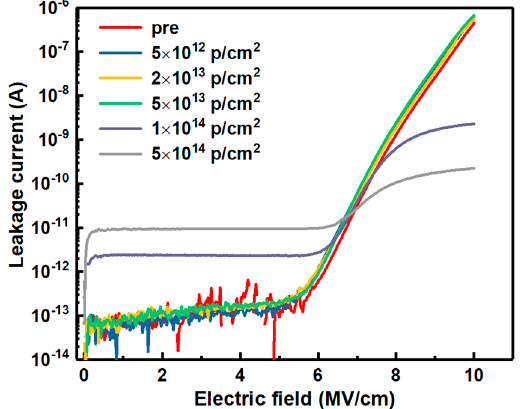
Figure 4. Typical current versus electric field of the samples with different doses of proton irradiation.